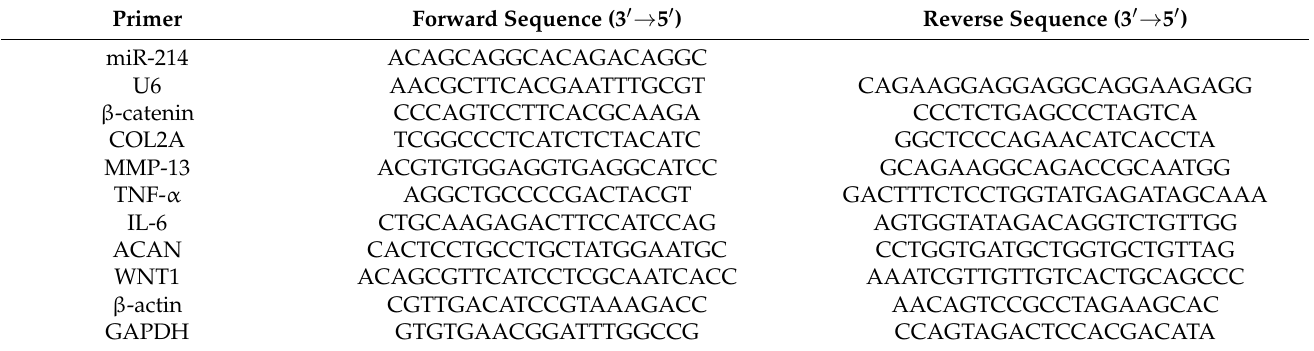
Table 3. Primer sequence.